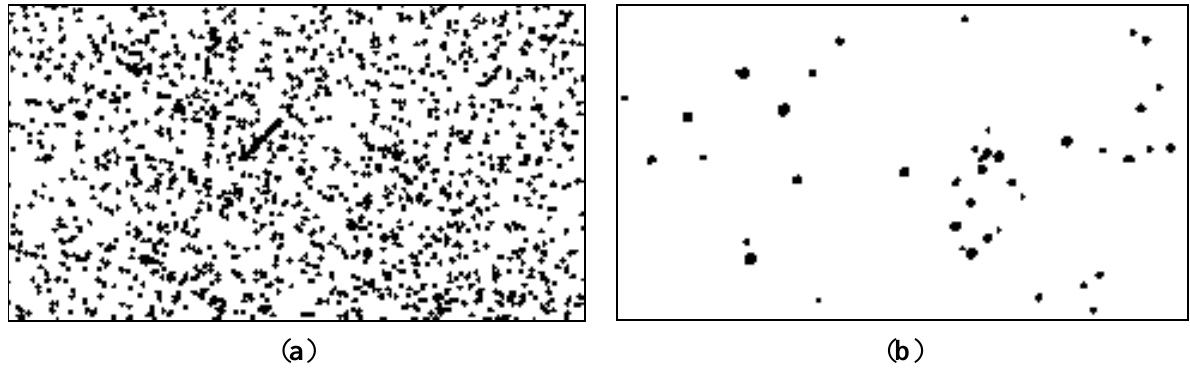
Figure 9. Dilated foreground star mask ( a ) and dilated background star mask ( b